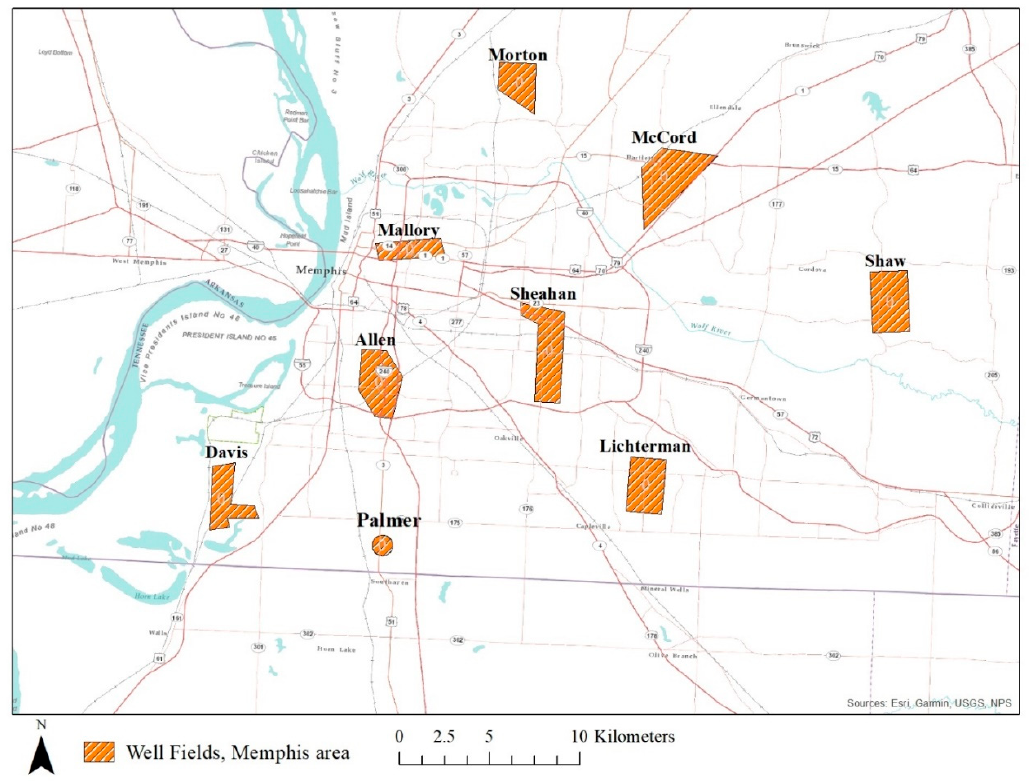
Figure 3. All active well fields in the Memphis area.